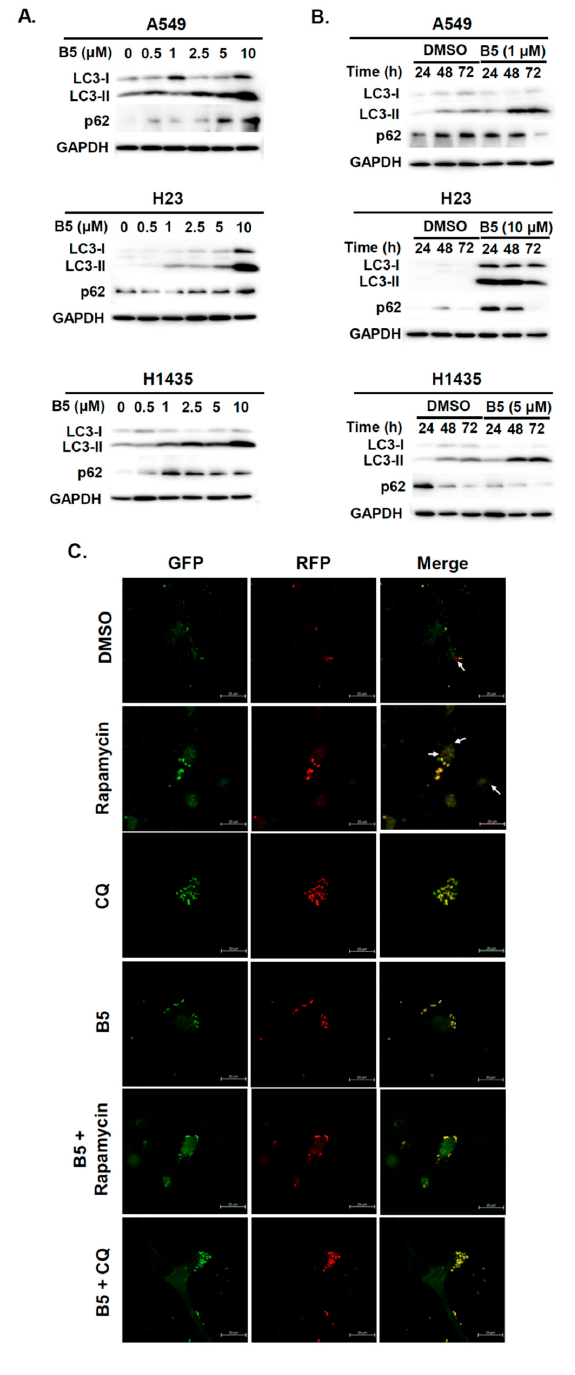
Figure 6. 9-O-farnesylberberrubine bromide regulates autophagy in NSCLC cells. A549, H23, and H1435 cells were incubated a control medium or that containing B5 ( A ) in various doses and ( B ) at multiple times. The expression of LC3-I/LC3-II and p62 was detected using western blot analysis. GAPDH was used as a loading control. Three independent experiments were performed, and a representative experiment was shown. ( C ) Autophagic flux in A549 cells was examined after transfecting the cells with pmRFP-EGFP-LC3; the cells were then incubated with B5 (1 µ M) or chloroquine (10 µ M) for 48 h. Autophagosome (yellow) and autolysosome (red) puncta were observed using confocal microscopy. DMSO was used as a negative control. Rapamycin was used as an inducer of autophagy; chloroquine was a blocker of the autophagic